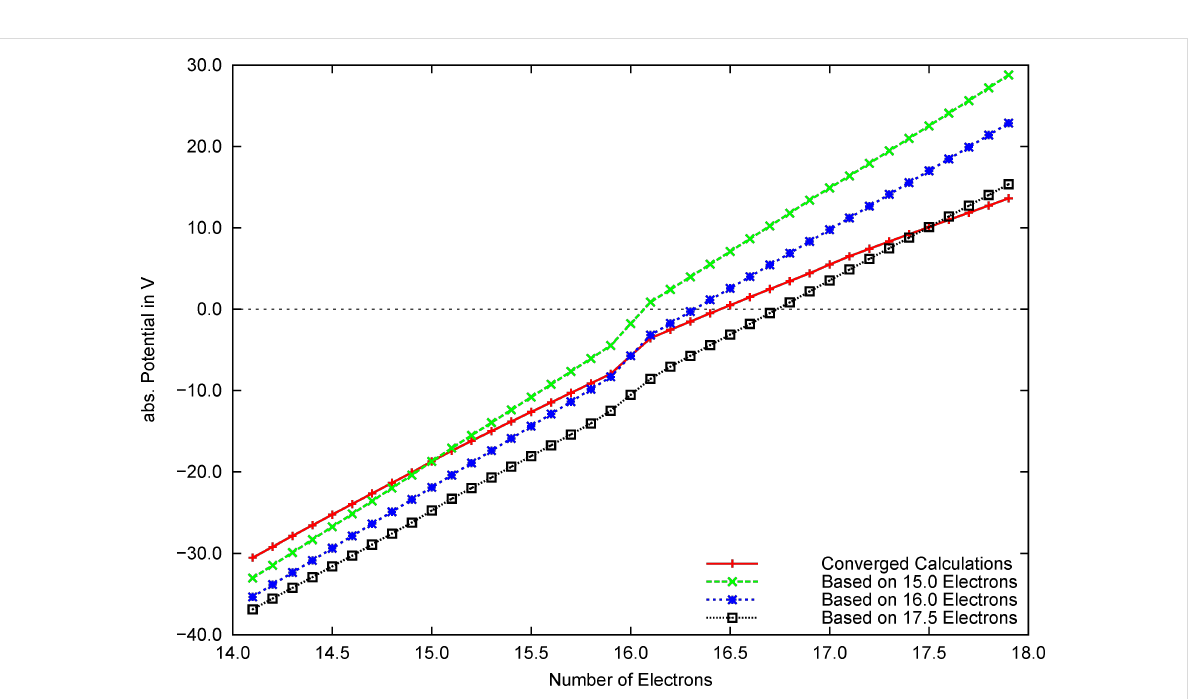
Figure 3: Chemical potential of the O 2 molecule, plotted against the number of electrons, calculated numerically and approximated by recalculation of the Fock matrix, respectively.